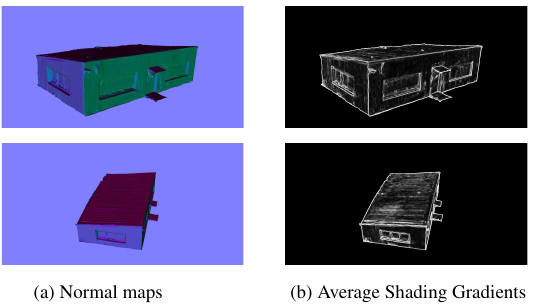
Figure 3. Gradient images created using Average Shading Gra- dients. (a) Normal maps of the model, (b) Resulting gradient